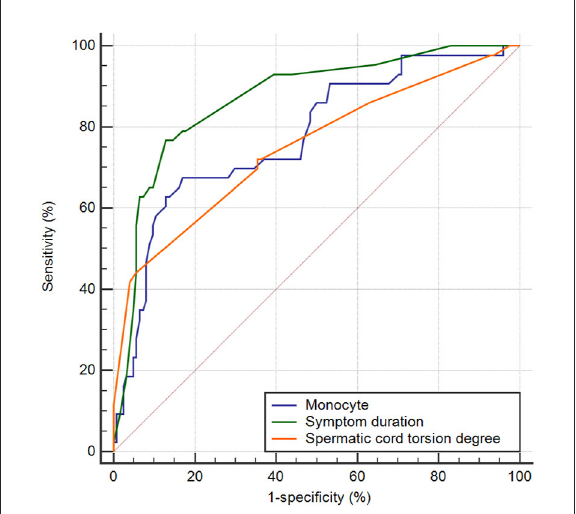
FIGURE2 ROC curves of the monocyte, symptom duration, and torsion degree for predicting testicular